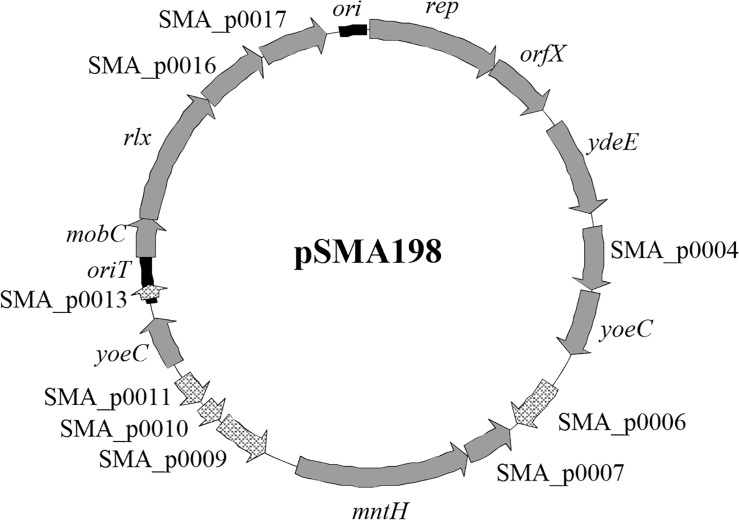
Annotated map of pSMA198. Black boxes indicate the position of ori and oriT. Solid grey arrows indicate positions of functional genes.Remaining light grey arrows indicate positions of predicted pseudogenes.